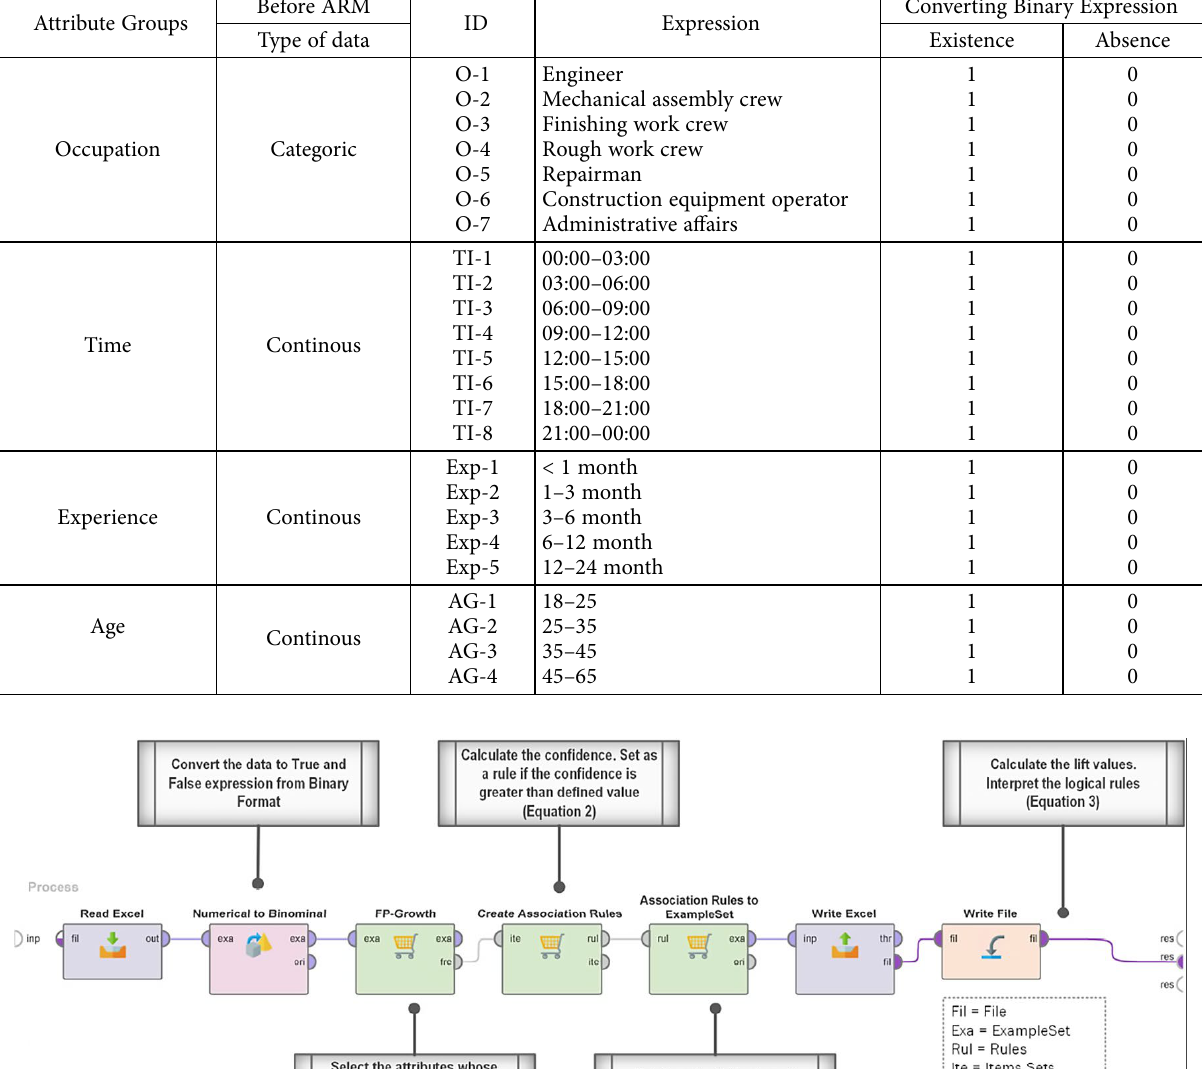
Table 2. The list of additional attributes